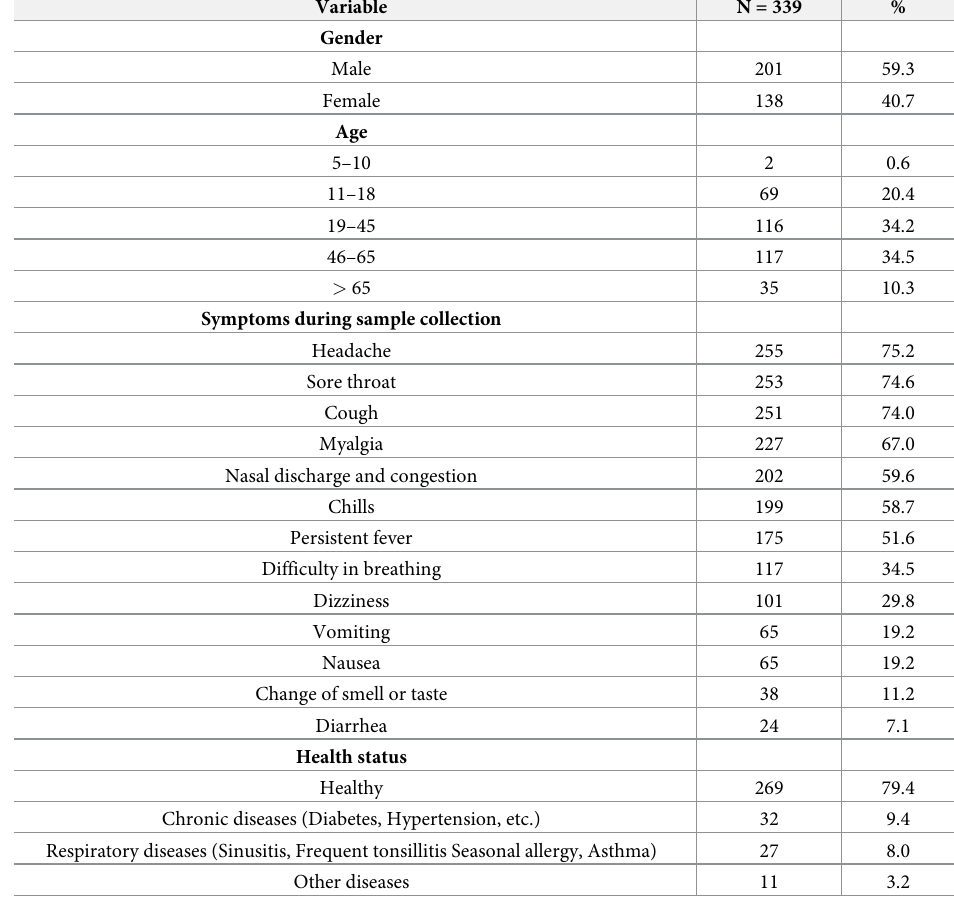
Table 1. Demographic and clinical status characteristics of study